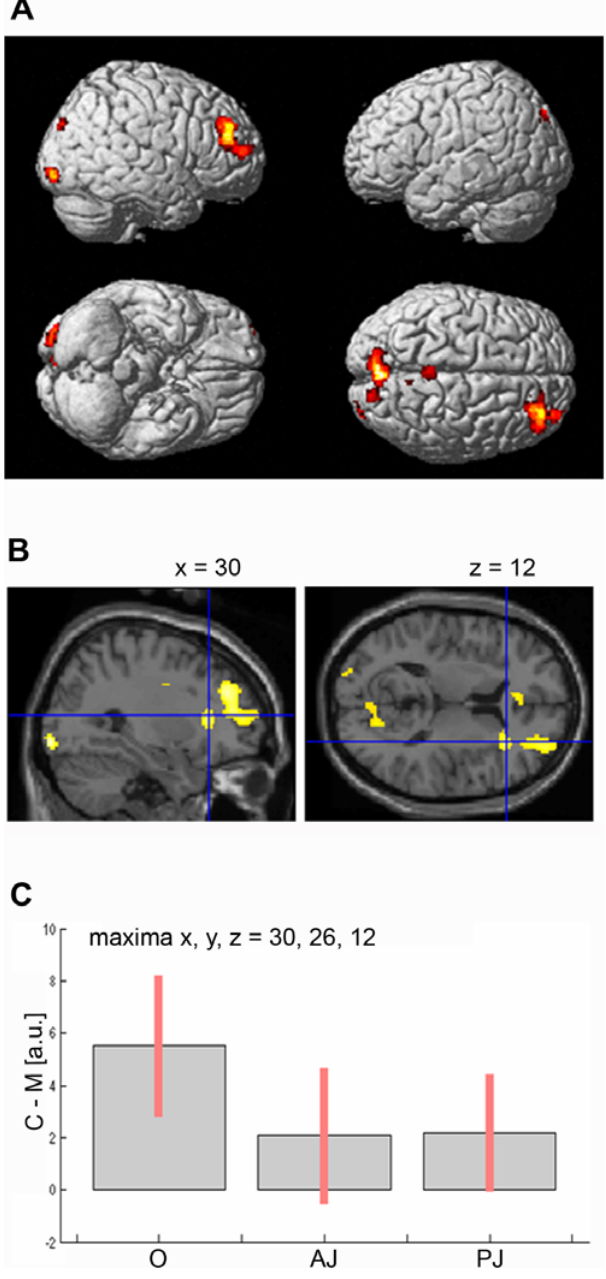
Figure 3. Brain activation in the contrast canonical vs. modified stimuli. a , Main effect of canonical vs . modified sculptures across conditions rendered onto the MNI brain template. b , Parasagittal and coronal view showing activations of the right insular region in the main effect. c , Activity profile of the right insula. For each condition (O, AJ, PJ) the signal plots show the difference between canonical (C) minus modified (M) sculptures in arbitrary units (a.u), + / 2 10% confidence intervals ( P -corrected ,